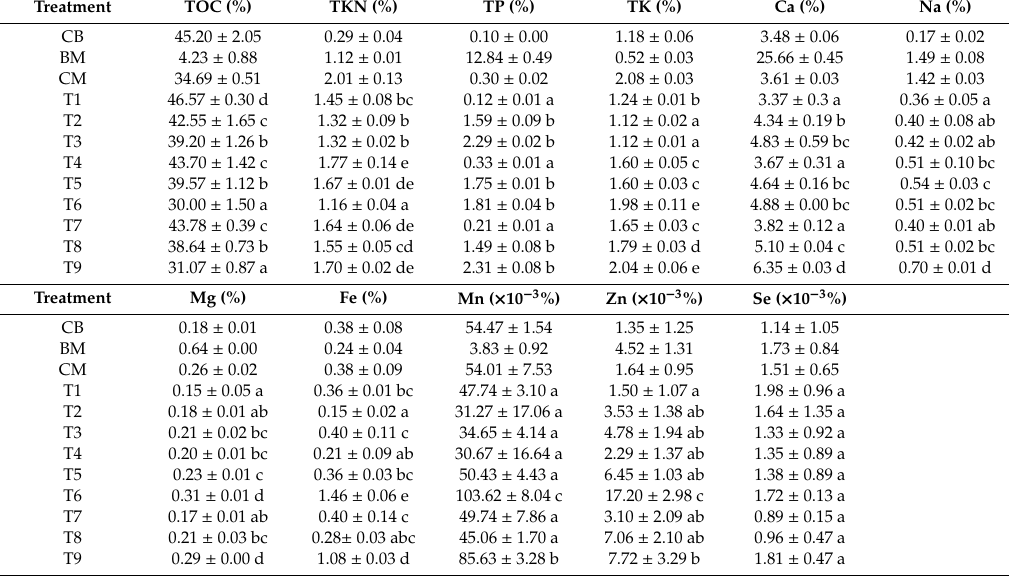
Table 2. Selected macronutrient and micronutrient content of chestnut burrs (CB), cow manure (CM), bovine bone meal (BM), and of the final composts of various mixture treatments. Treatments T1–T9 are described in Table